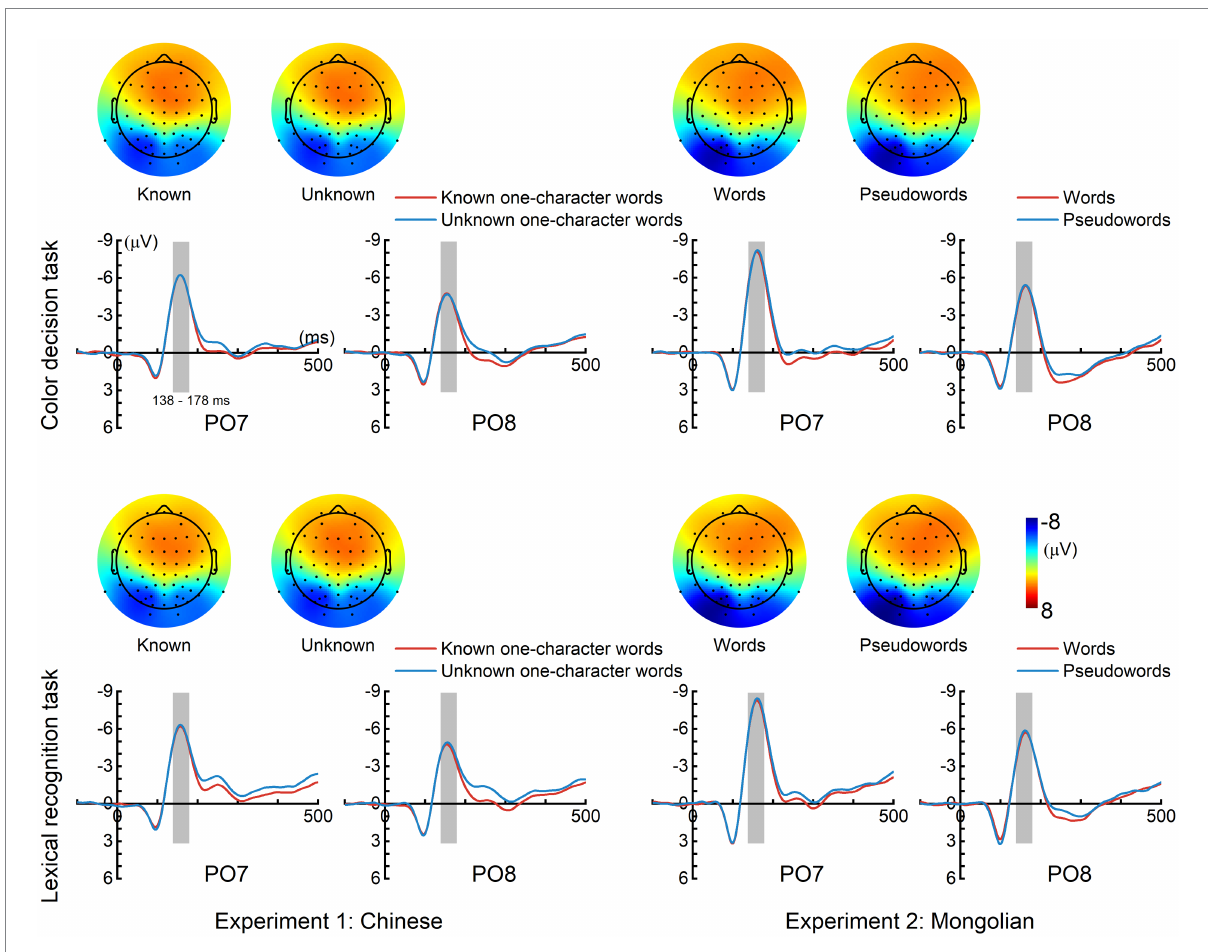
FIGURE 2 Grand-averaged event-related potentials (ERPs). A prominent N170 response was elicited in each condition and each experiment. The time interval (138–178 ms), represented by gray bars was used for calculating the mean N170 amplitudes. The topographic maps (mean magnitudes within 138–178 ms) of N170 for each condition are